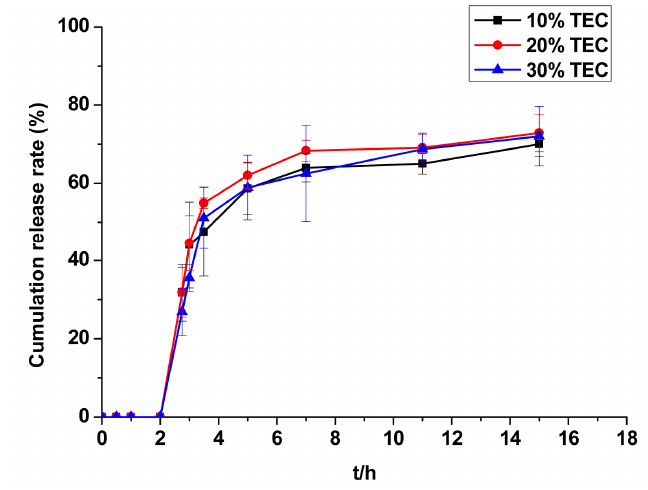
Figure 5. The effect of TEC dosage on the release of CAP from CCMS enteric coated tablets. Each point represents the mean ± SD. Abbreviations: TEC, triethyl citrate.